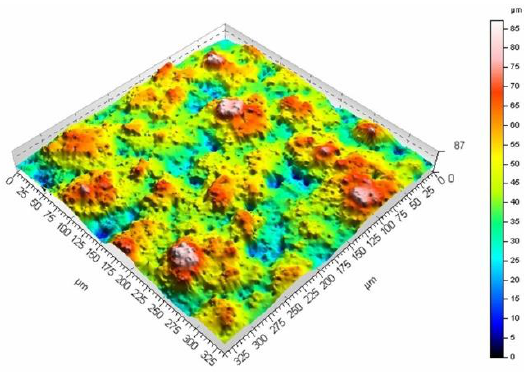
Figure 12. Surface morphology produced from a pulse duration of 250 ns and velocity of 200 mm/s.